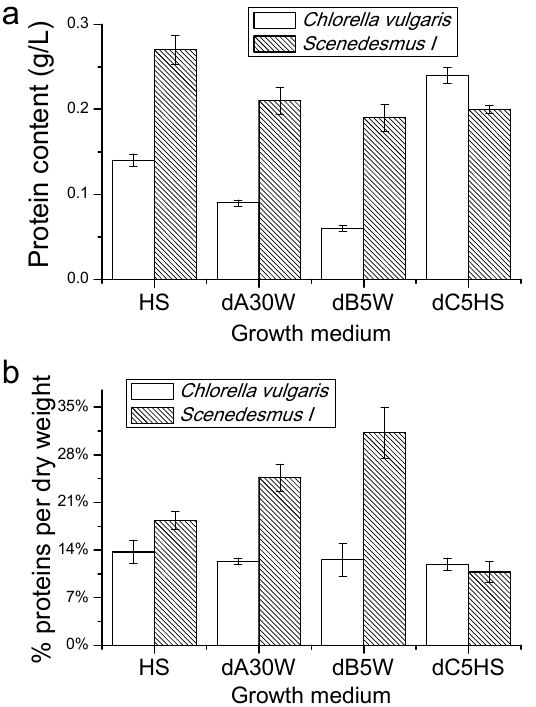
Figure 4. Protein content of algae cultures: ( a ) total protein content (g/L) accumulated in microalgae cultures; and ( b ) percentage of protein content on the overall biomass harvested.